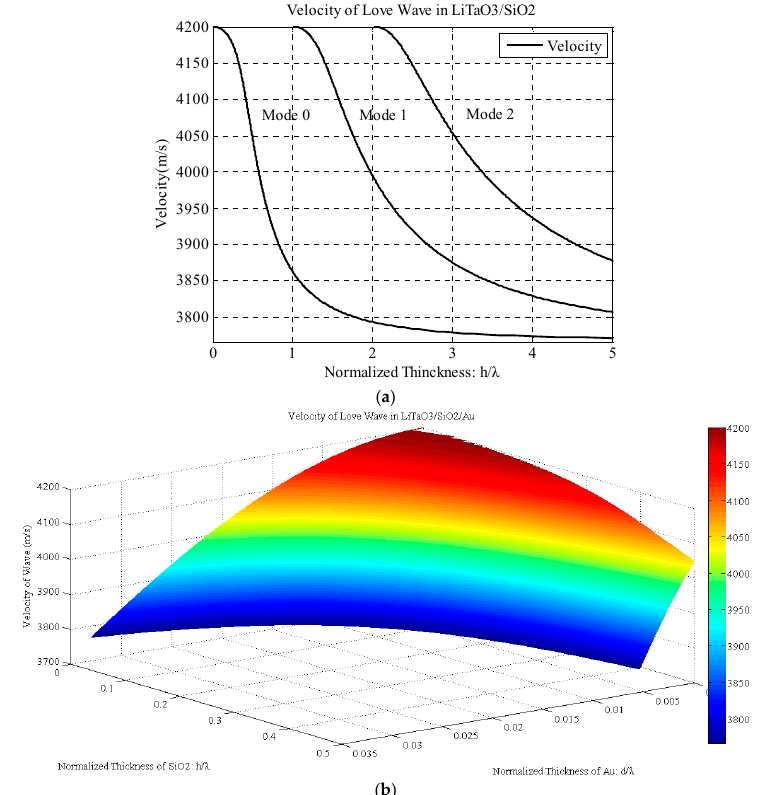
Figure 2. Velocity of Love wave in ( a ) LiTaO 3 /SiO 2 device; ( b ) LiTaO 3 /SiO 2 /Au device.